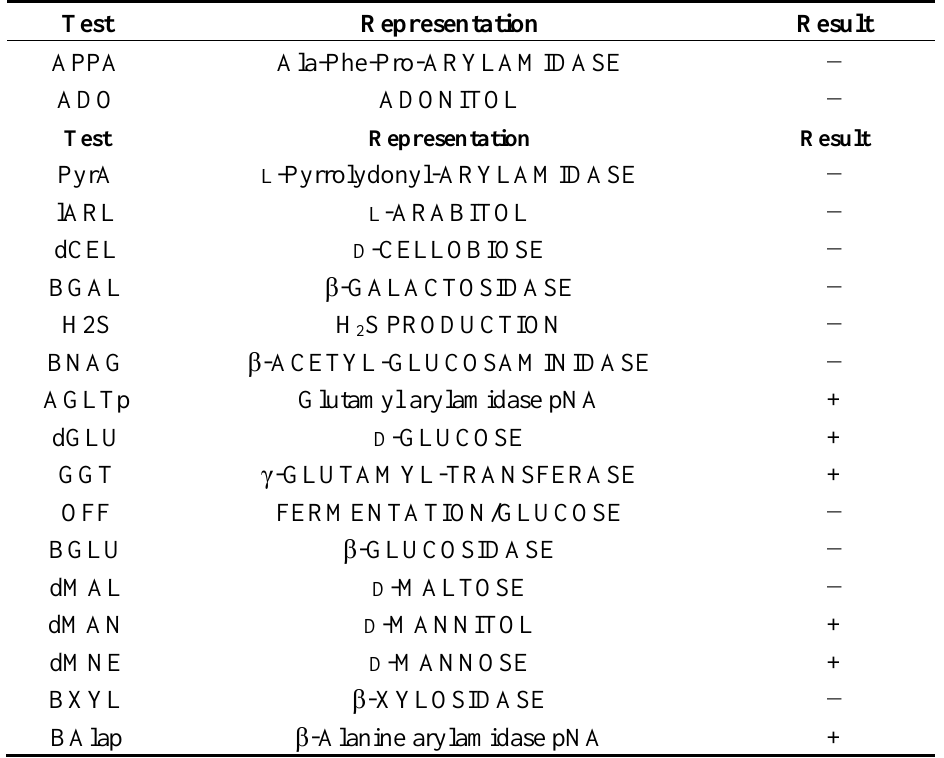
Table A1. Biochemical characteristics of strain HI47 identified by using GN card in VITEK 2